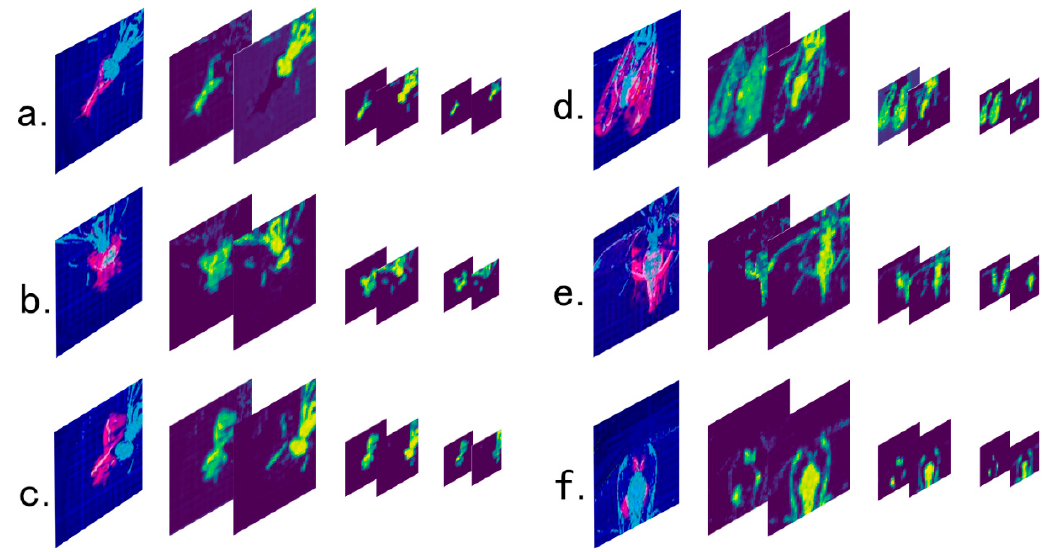
Figure 10. Feature map of the six grooming behaviors. Figure ( a – f ) are the spatio-temporal feature images of foreleg grooming, head grooming, mid grooming, wing grooming, abdomen grooming and hind leg grooming, and neural network feature maps extracted by our trained detection model. The first image of each group is the original feature image, the second is the temporal feature map obtained after the first pooling of neural network, the third is the spatial feature map obtained after the first pooling, the fourth is the temporal feature map obtained after the second pooling, the fifth is the spatial feature map obtained after the second pooling, the sixth is the temporal feature map obtained after the third pooling, and the seventh is the spatial feature map obtained after the third pooling.